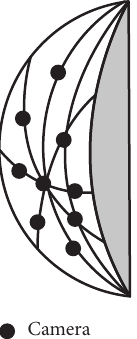
Figure 3: Placements of the cameras.